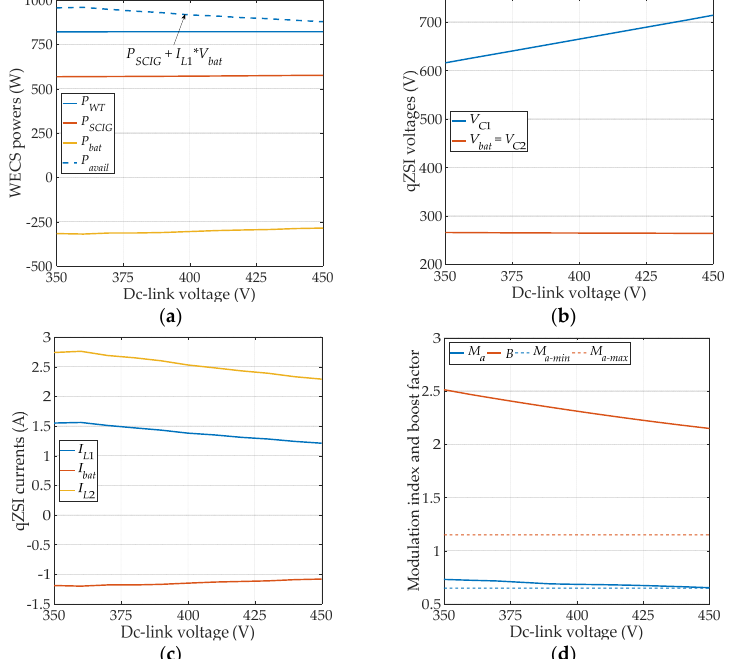
Figure 9. Steady-state characteristics for DC link voltage variation ( v w = 9 m/s, V ac = 230 V): ( a ) WECS powers; ( b ) qZSI voltages; ( c ) qZSI currents; ( d ) modulation index and boost factor.